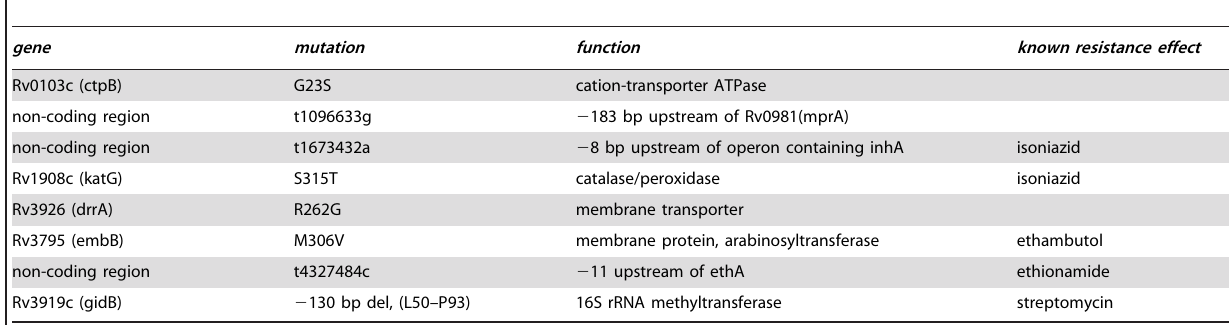
Table 6. Polymorphisms shared between the drug-resistant strains KZN-V2475 and KZN-R506, relative to KZN-V4207, and not found in drug-susceptible strains.